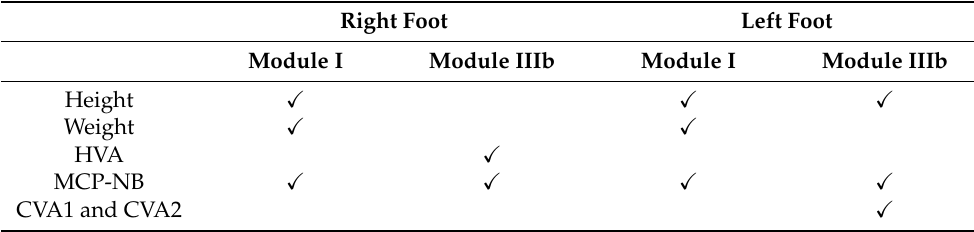
Table 8. Comparisons of personal features for Modules I and